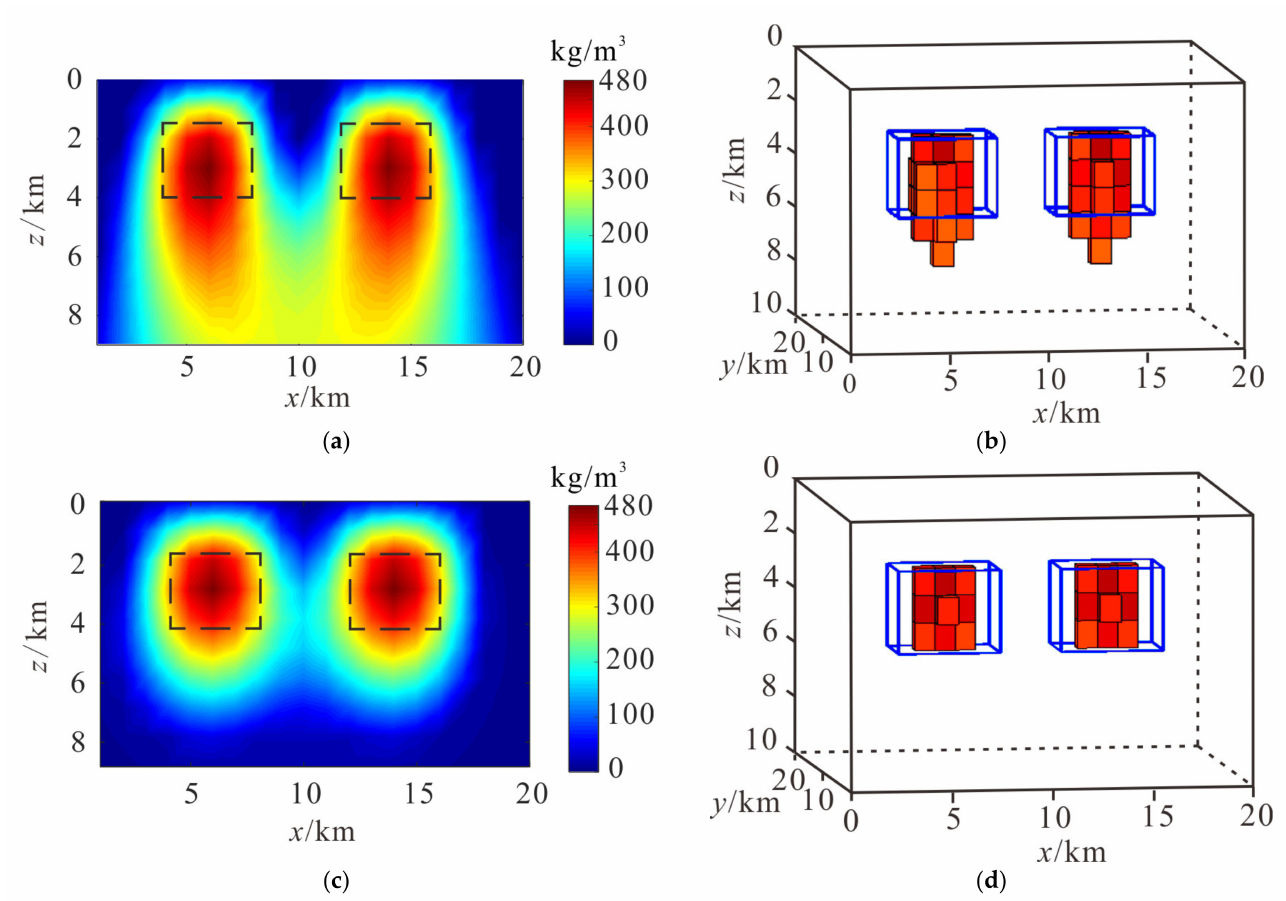
Figure 7. Model tests of two prisms in the same depths. ( a ) Density slice (y = 10 km) by data combined joint inversion method of airborne gravity and its gradient data. ( b ) 3D density distribution (larger than 370 kg/m 3 ) by data combined joint inversion method of airborne gravity and its gradient data. ( c ) Density slice (y = 10 km) by the cooperate density-integrated inversion method. ( d ) 3D density distribution (larger than 370 kg/m 3 ) by the cooperate density-integrated inversion